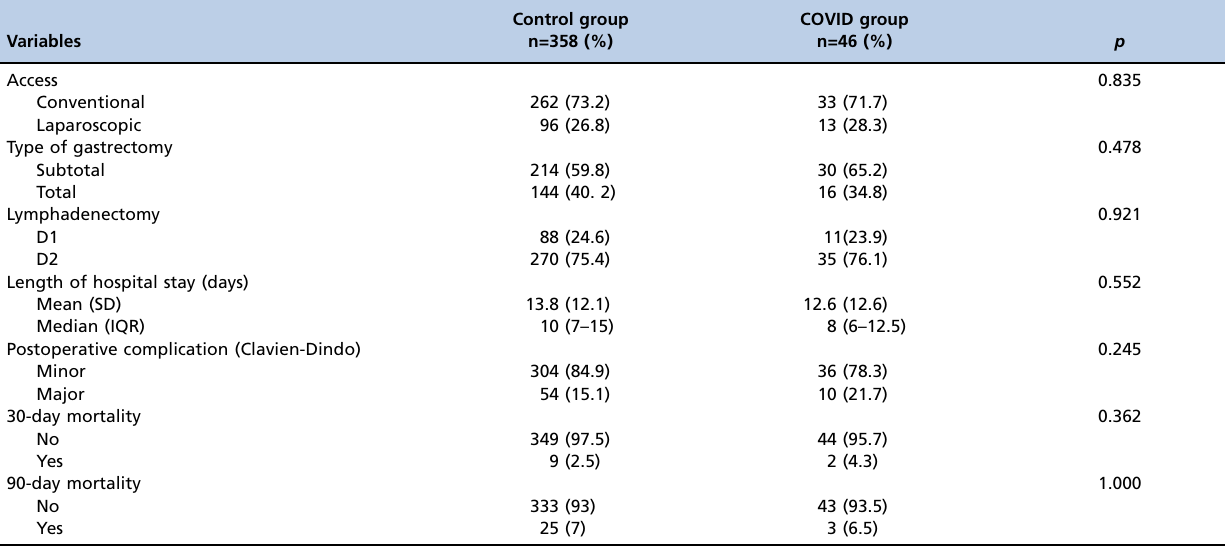
SD, standard deviation; IQR, interquartile